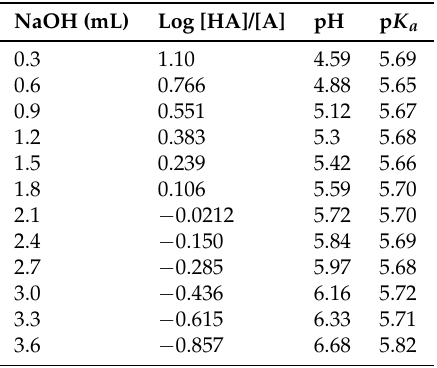
Table 5. Calculations of the acidity constants of 8 at T = 23 ◦ C (Table 1), according to the results of one titration. p K a = 5.70 as the arithmetic mean of all 12 values in the set. NaOH (mL) Log [HA]/[A] pH p K a